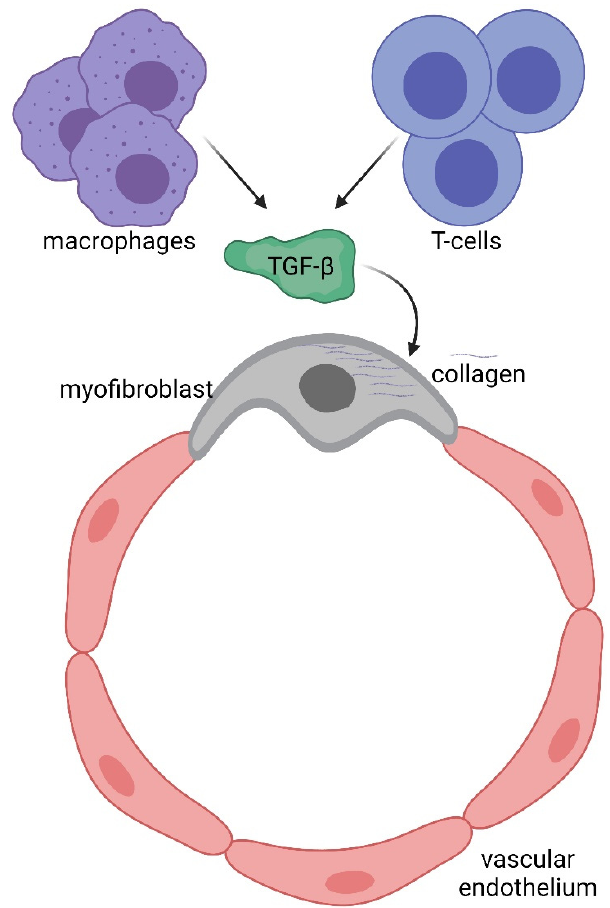
Figure 5. Immune system involvement in endothelial-to-mesenchymal transition (EndoMT).